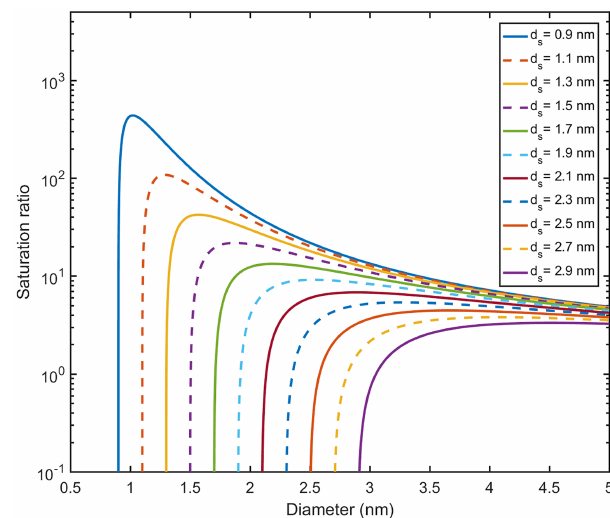
Figure 9. Köhler curves showing the equilibrium particle size at dif- ferent saturation ratios for LVOC. The line color shows the diameter of the seed particle ( d s ). The maxima of the curves correspond to the critical